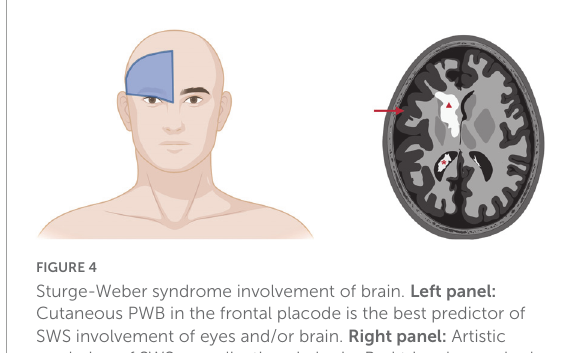
FIGURE4 Sturge-Weber syndrome involvement of brain. Left panel: Cutaneous PWB in the frontal placode is the best predictor of SWS involvement of eyes and/or brain. Right panel: Artistic rendering of SWS complications in brain. Red triangle, cerebral calcification; red arrow, leptomeningeal thickening and cerebral atrophy; red asterisk, enlarged choroid plexus. Images created using